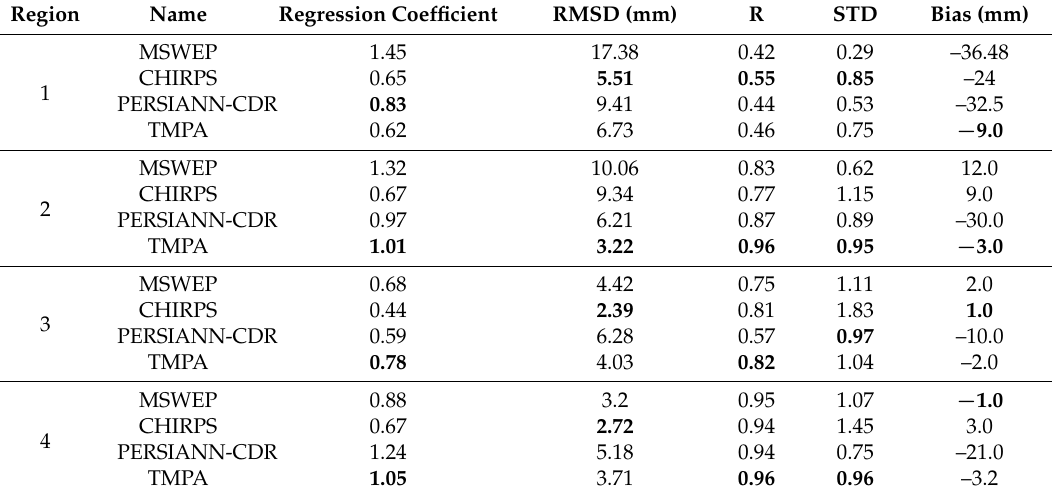
Figure 7. Scatterplots of annual mean precipitation for in-situ and GPPs at selected locations. ( a – d ) are equivalent to regions 1, 2, 3 and 4 in Table 1. Table 3. Descriptive statistics of GPPs versus in-situ precipitation at annual time scale.